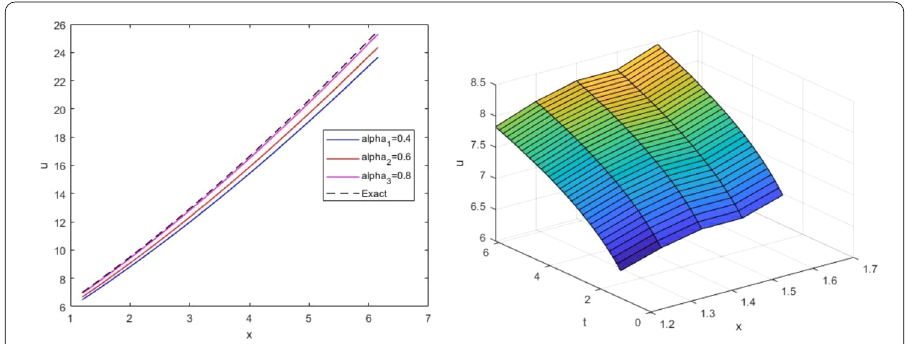
Figure 2 Comparison between the exact solution and the approximate solution of Example 4.2 for different values of α